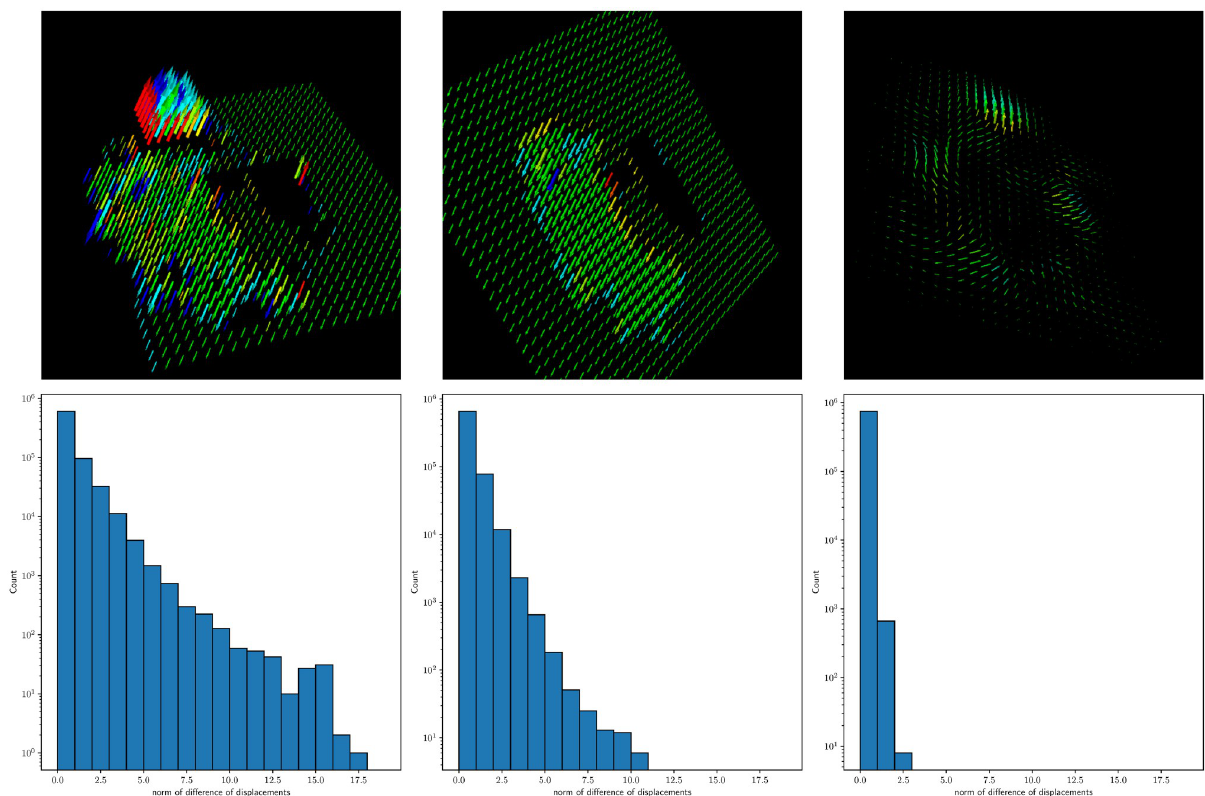
Fig 4. Examples of the visualized displacement fields and their corresponding histogram statistics. The histograms are based on the smoothness terms for all pairs of adjacent voxels with α = 1 and d = 1 . From left to right: the integrated flow with less restriction on local smoothness; the integrated flow with stronger local smoothness; ANTs